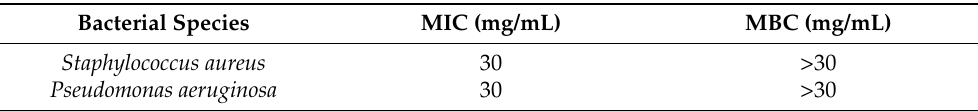
Table 2. The antibacterial activity of the sports beverage. Bacterial Species MIC (mg/mL) MBC (mg/mL) Staphylococcus aureus 30 >30 Pseudomonas aeruginosa 30 >30